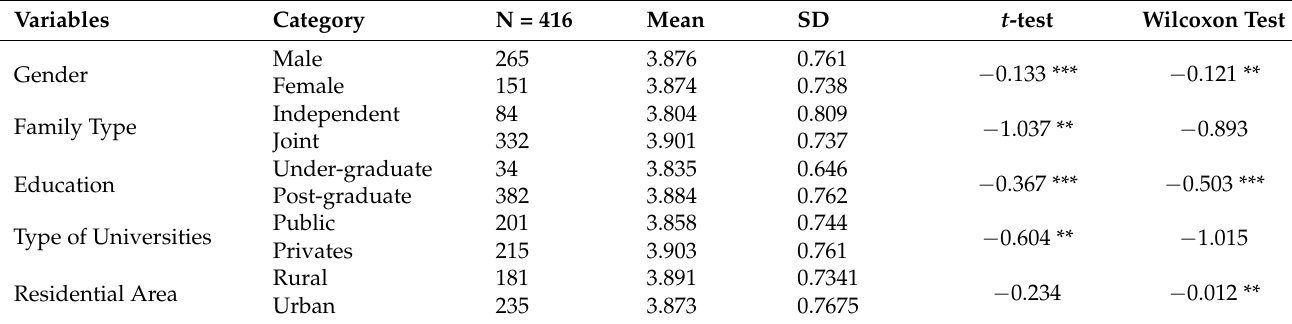
Table 6. Entrepreneurial intention among the